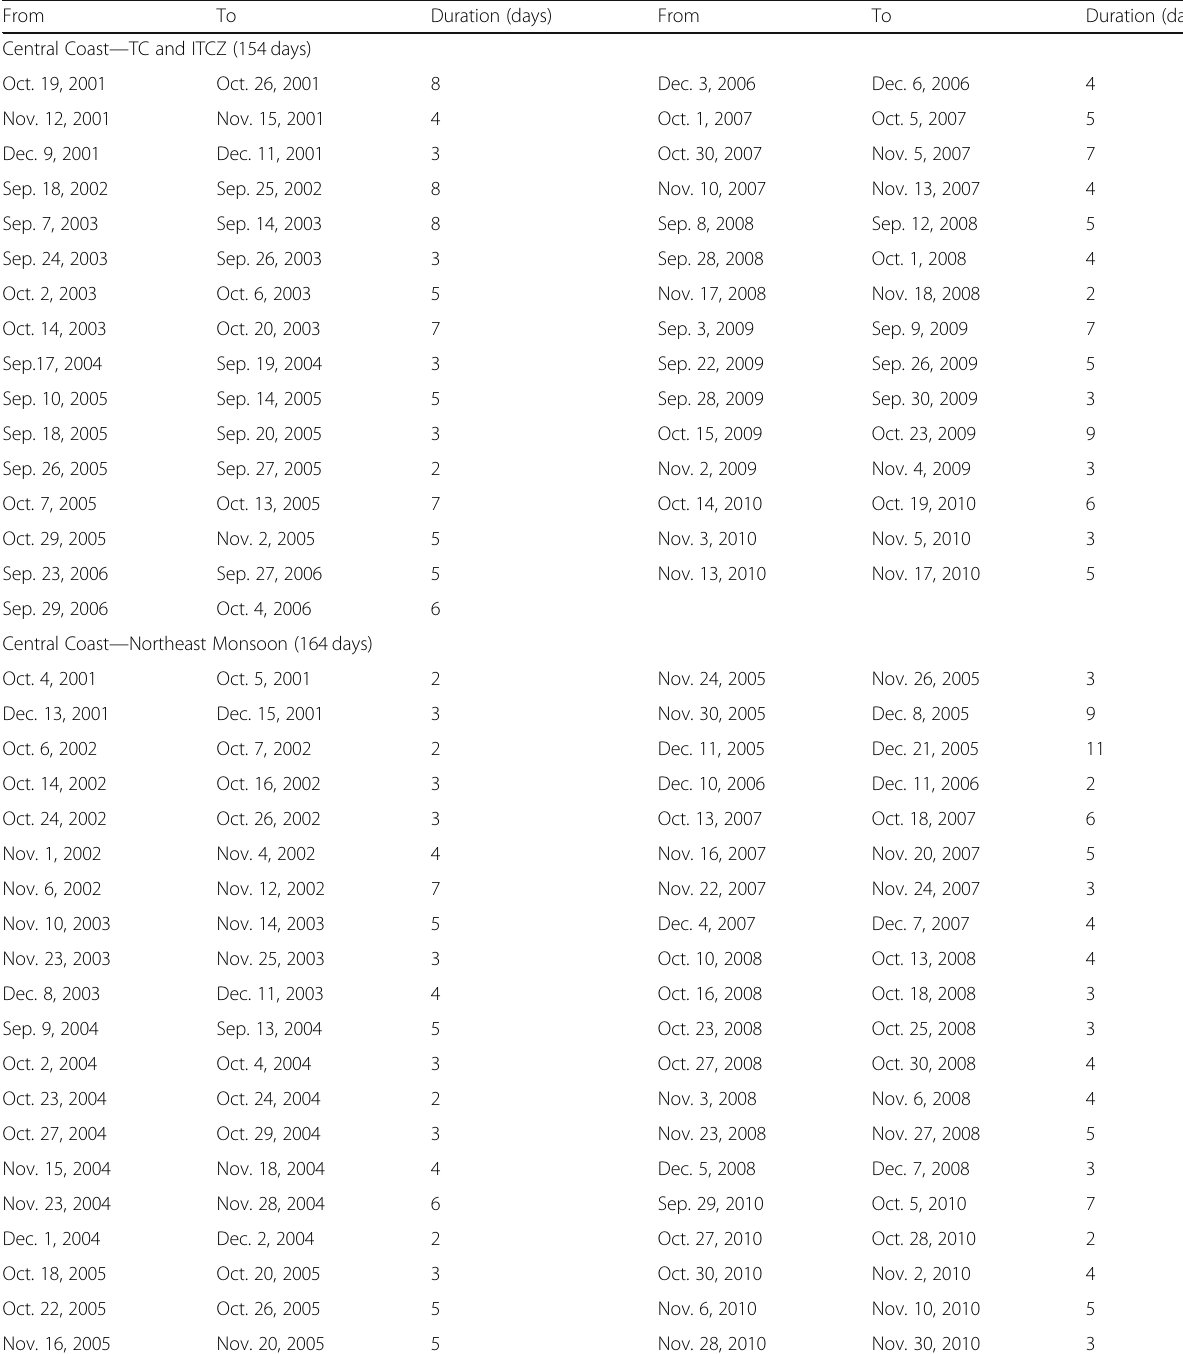
Table 3 WHR events during 2001 – 2010 detected in this study in the VCC and caused by TI and